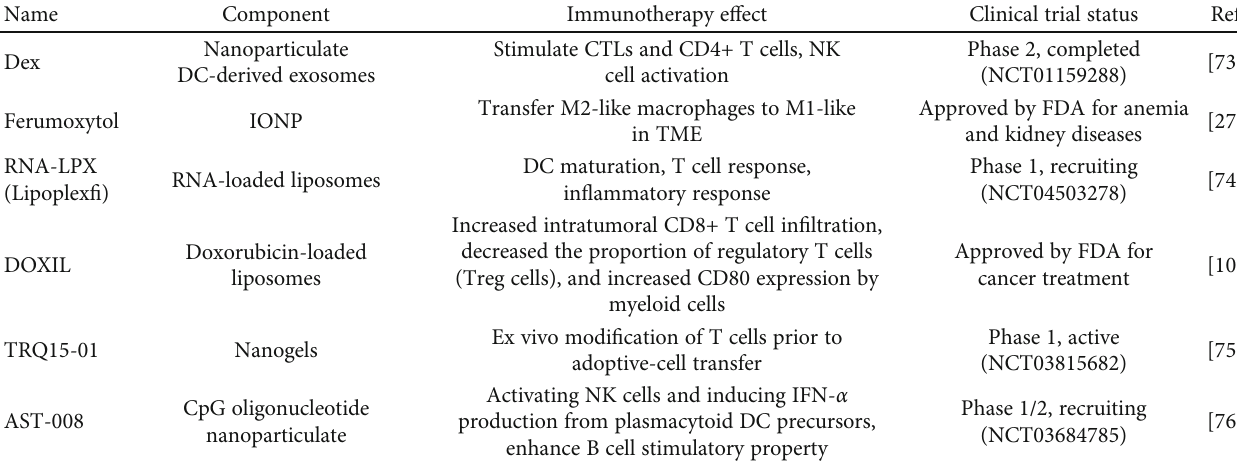
Table 3: Some applications of bio-nanomaterial approved by FDA or in clinical trials in microenvironment therapy.